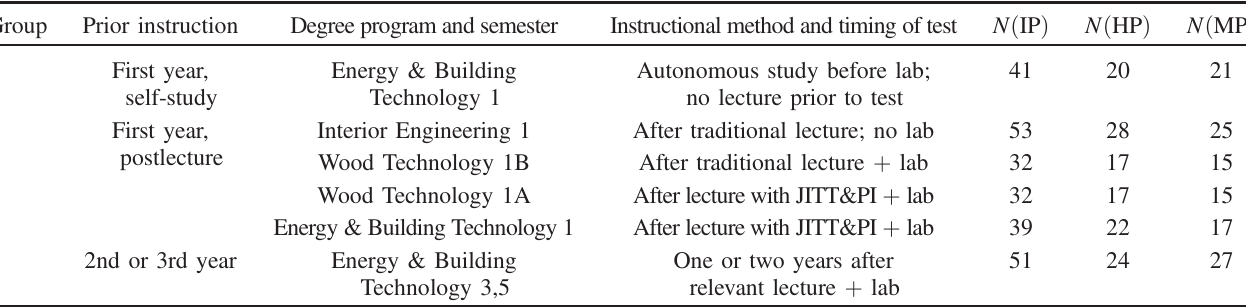
TABLE I. List of populations (groups) involved in the study and relevant details, including timing of the test, instructional method, and number of participants in each group. JITT, PI, and lab denote Just-in-Time Teaching, Peer Instruction, and a corresponding laboratory experiment as described in Sec. IV. The last three columns refer to the numbers of students answering the corresponding question (IP ¼ inclined-pipe question; HP ¼ horizontal-pipe question; MP ¼ manometer-pipe question; see Sec.